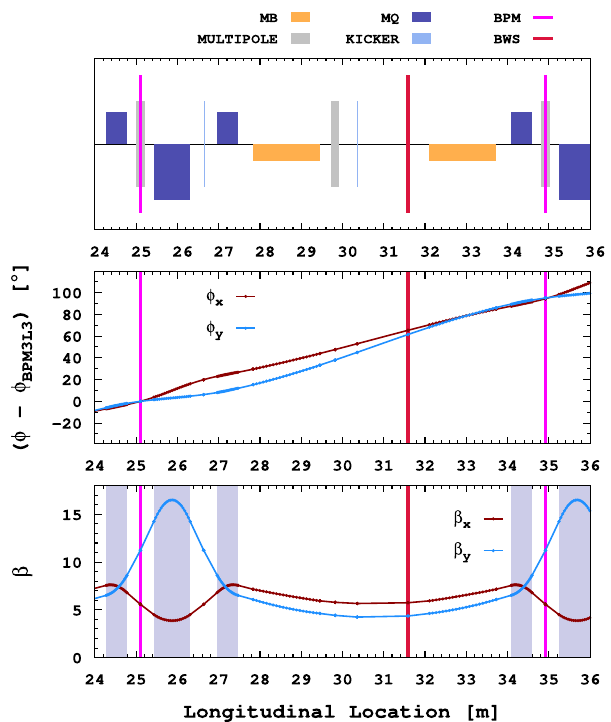
FIG. 12. MAD - X layout of the PS booster lattice in the vicinity of wirescanner (top) together with simulated phase advance (center) and β functions (bottom). The wirescanner location is indicated by a red